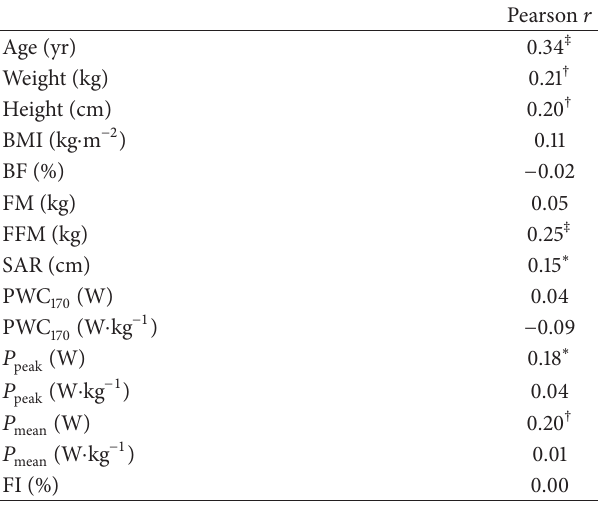
Table 3: Pearson correlations of nutritional knowledge with anthro- pometry, body composition, flexibility, and aerobic and anaerobic